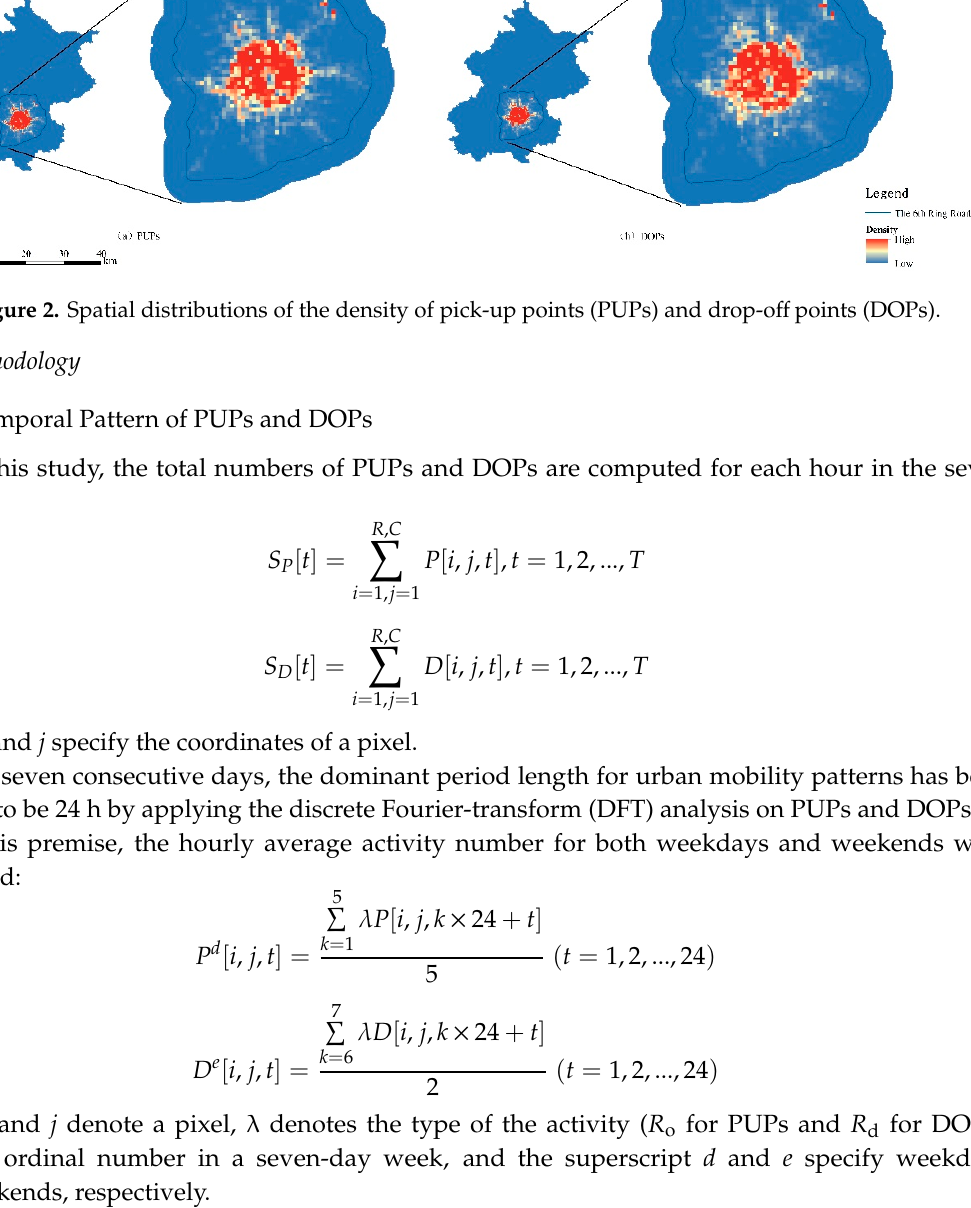
Table 1. GPS data in Beijing city.